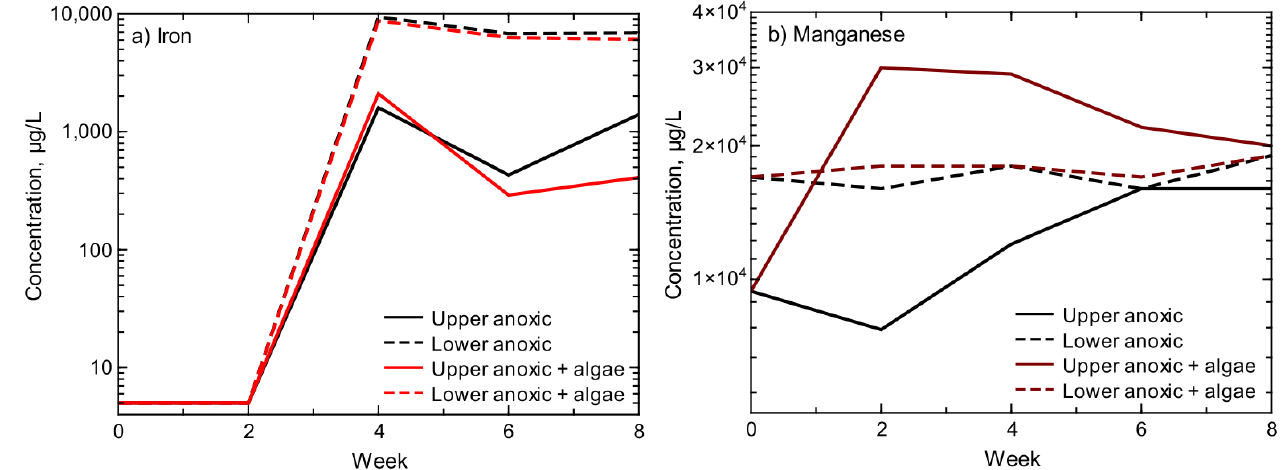
Figure 3. Iron and manganese concentrations in porewater extracted from sediment cores collected from Coeur d’Alene Lake that were exposed to anoxic and anoxic + algae conditions over an 8-week period (modified from [21]). The upper (2.5-cm depth) and lower (12.5-cm depth) iron and manganese concentrations are from the analysis of the porewater extracted from the corresponding sediment samples collected for X-ray absorption spectroscopy.